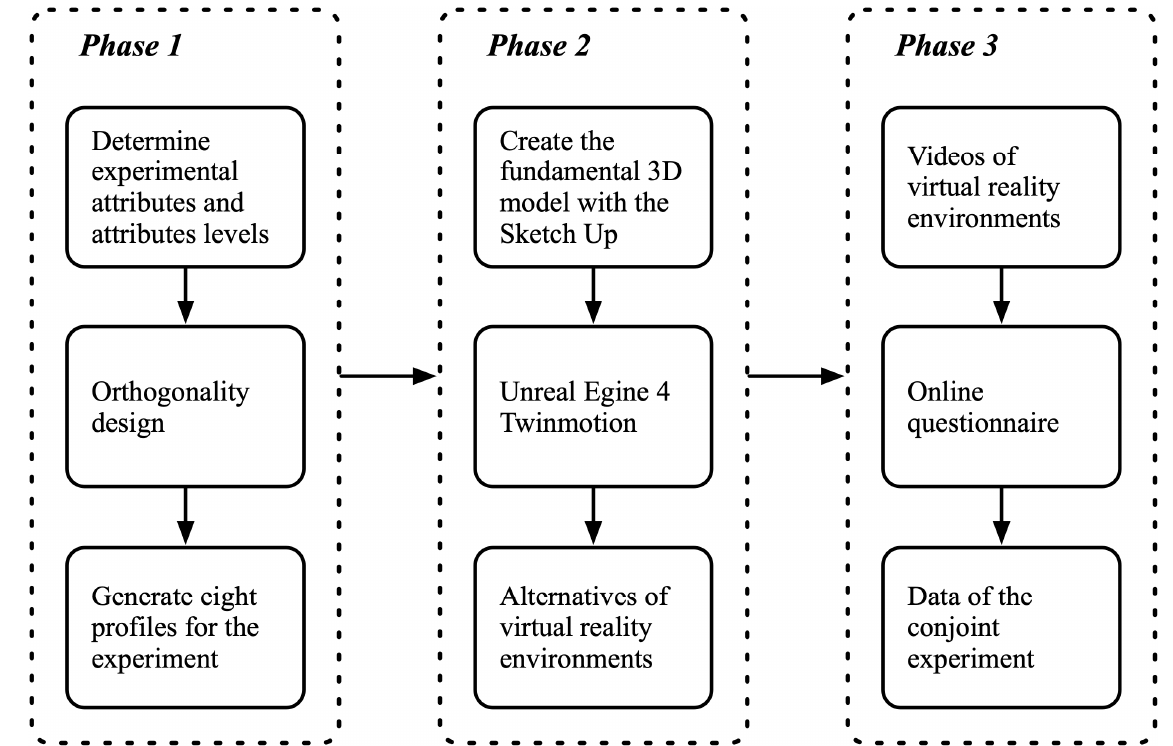
Figure 1. The flowchart of the conjoint experiment design.